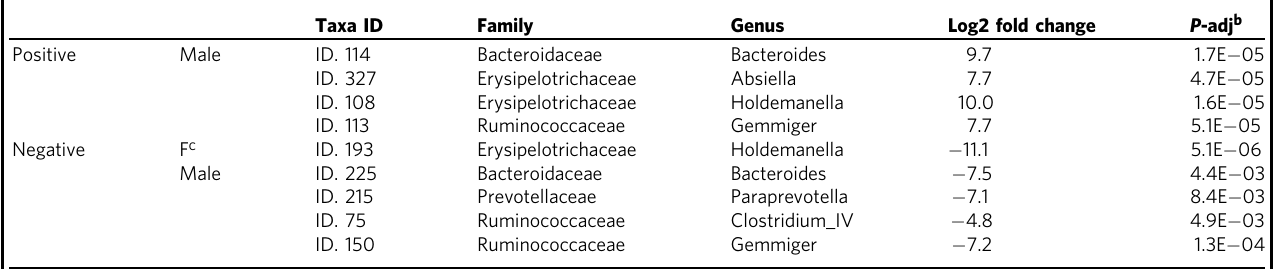
Table 2 Taxa associated with android fat ratio (full model a